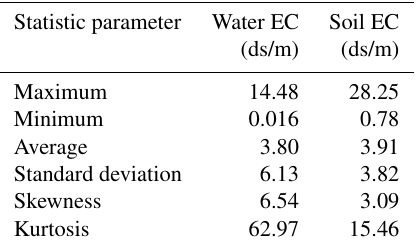
Table 4. Descriptive statistics of the water and soil EC.